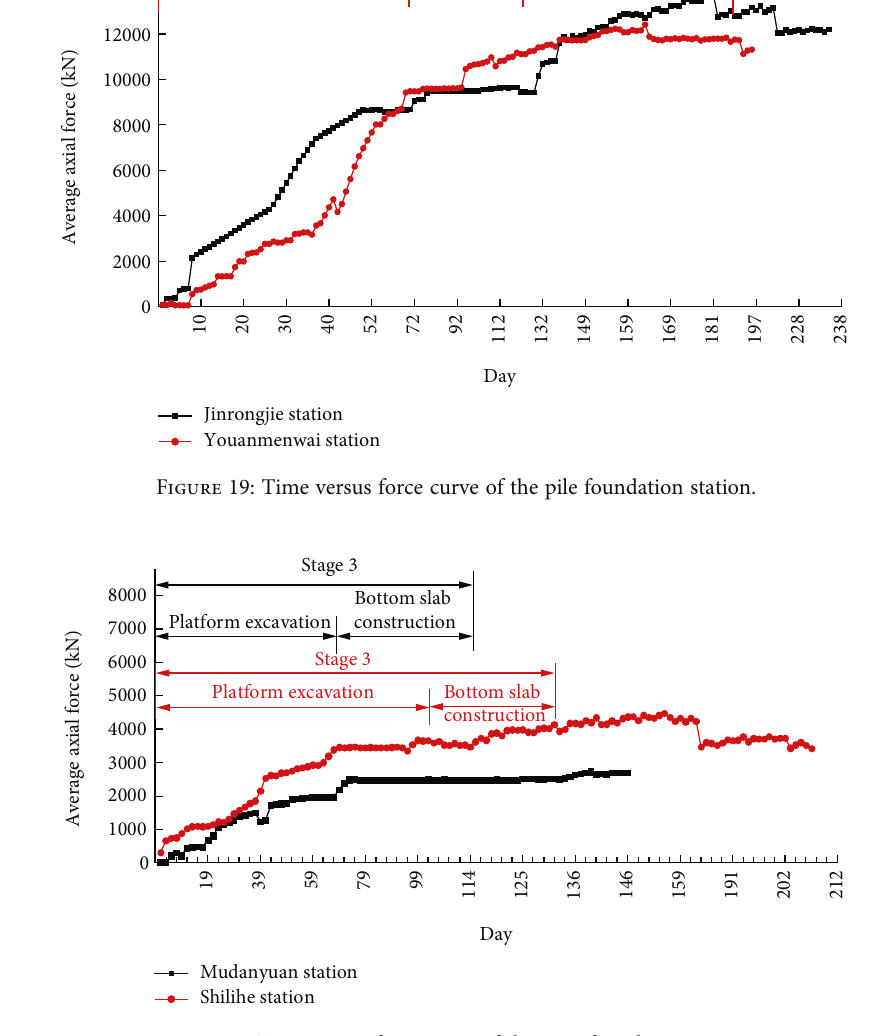
Figure 20: Time versus force curve of the strip foundation